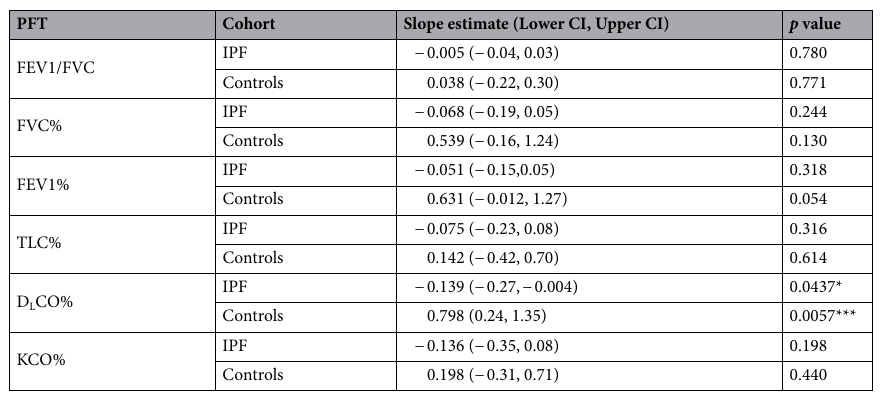
Table 4. Relationship between estimated PVV and PFT measures in control and IPF cohorts. Data are given for the slope estimate (mL/%PFT measure) and upper and lower confidence interval (CI) values (mL/%PFT measure). Independent t-test p values indicated by: *(significance at the 0.05 level), **(significance at the 0.01 level), ***(significance at the 0.001 level). FEV1 forced expired volume at 1 s; FVC forced vital